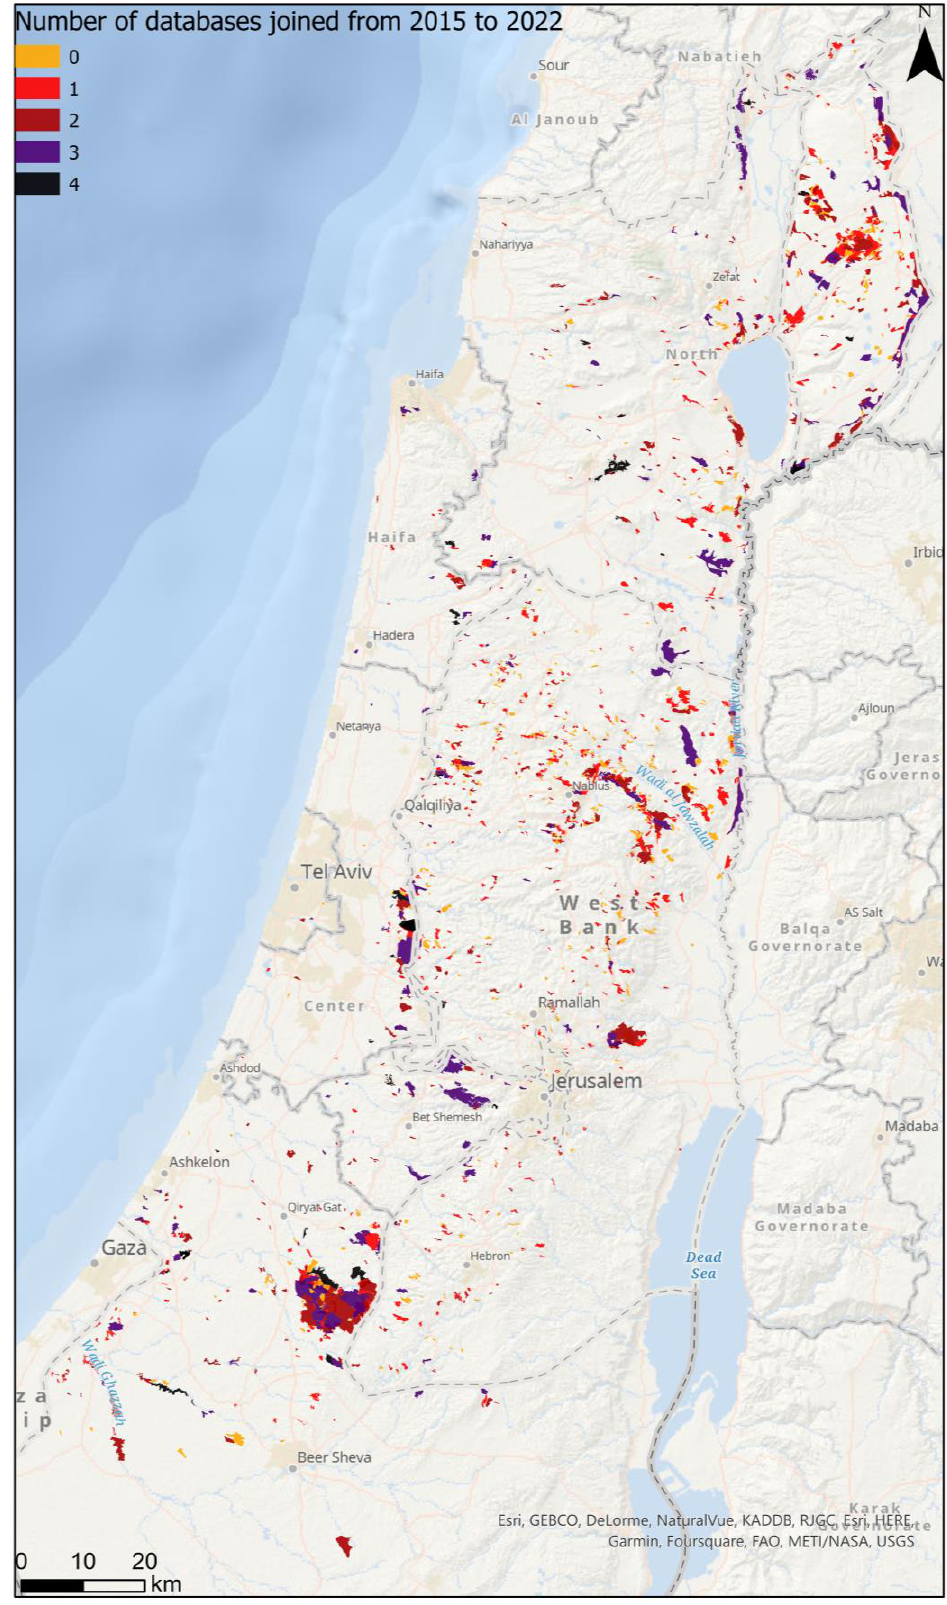
Figure 8. Wildfire scars from 2015 to 2022 colored by number of databases joined to INPA database.